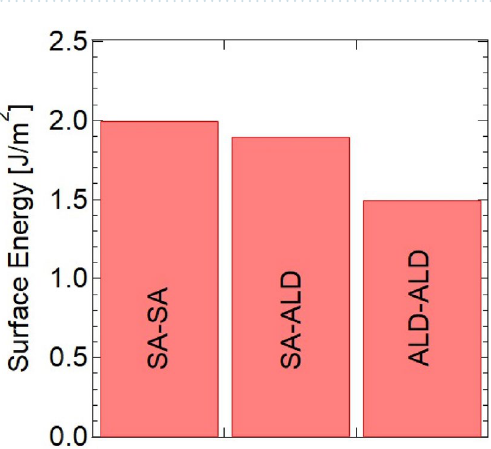
Figure 5. Elemental analysis using cross-sectional STEM-EDX.